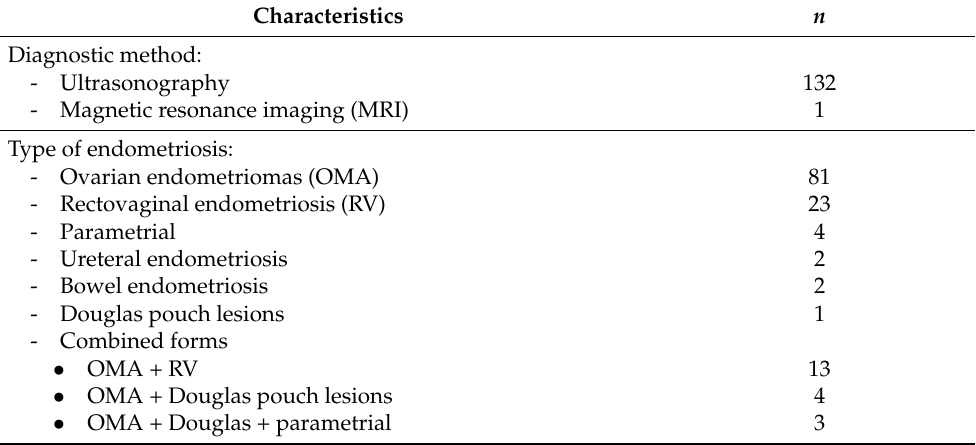
Table 1. Characteristics of participants with a nonsurgical diagnosis of the disease. Characteristics